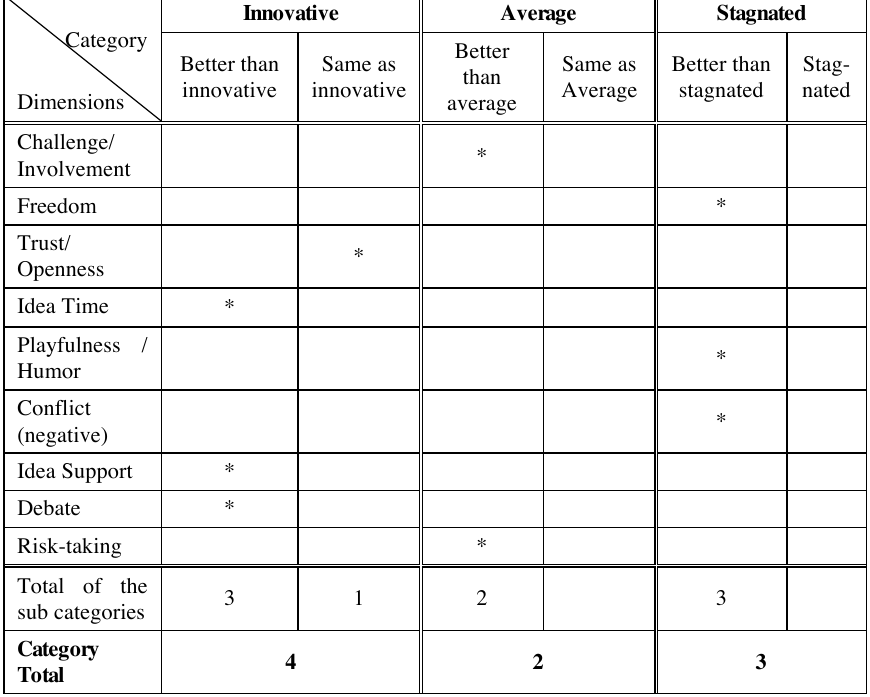
Table 5. The assessment results in relation to the three categories: innovative, average and stagnated organizations Innovative Average Stagnated Category Same as innovative Dimensions